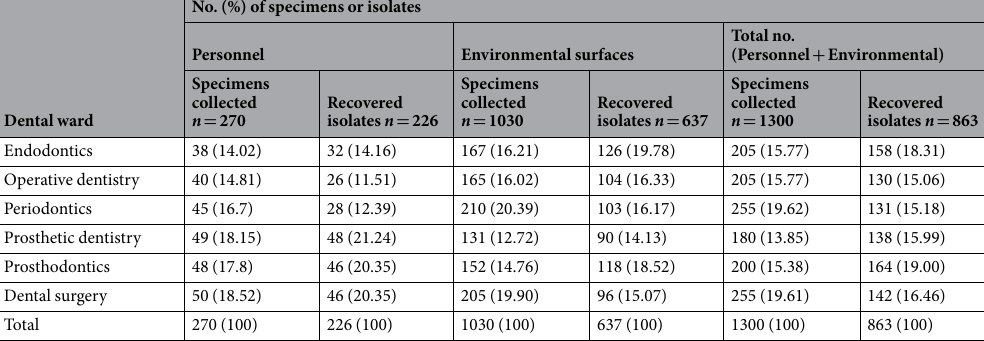
Table 3. Ward distribution of the specimens collected in this